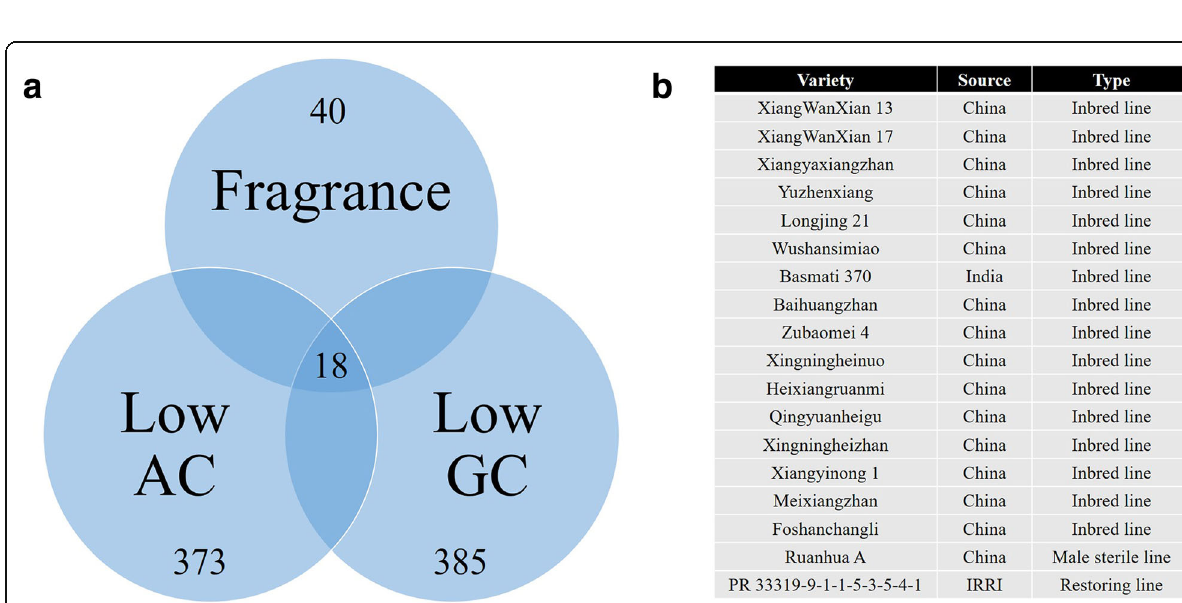
Fig. 7 Screening results of favorable alleles. a Venn diagrams of rice lines with fragrance, low amylose content (AC) and low gel consistency (GC); b Eighteen rice lines harboring the three the favorable alleles of GBSSI (T allele), SSIIa (TT allele), and Badh2 (Del allele)